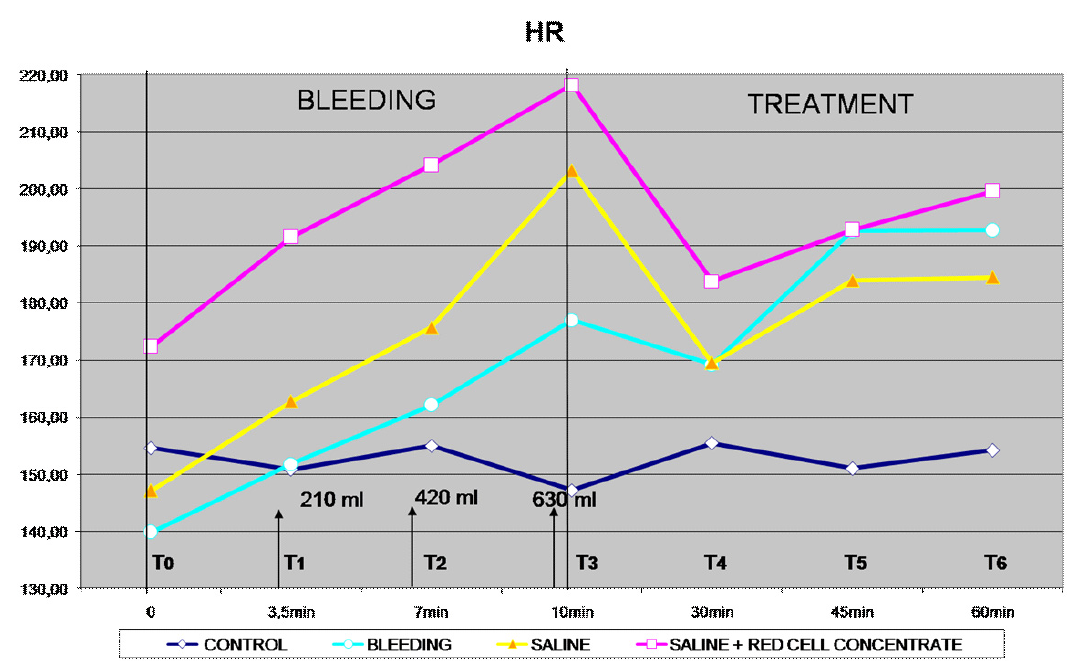
FIGURE 2 - Evolution of mean arterial blood pressure after hemorrhagic insult and employed